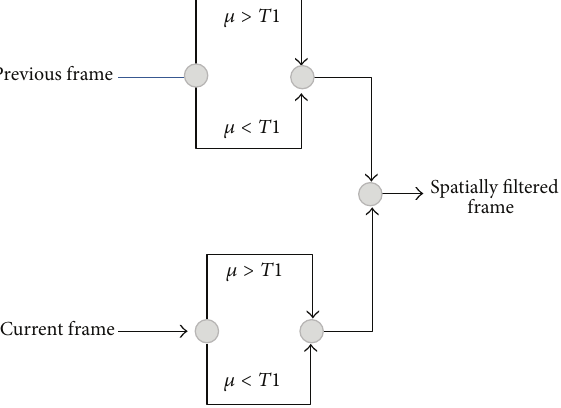
Figure 1: Block diagram of the spatial Winier filter.